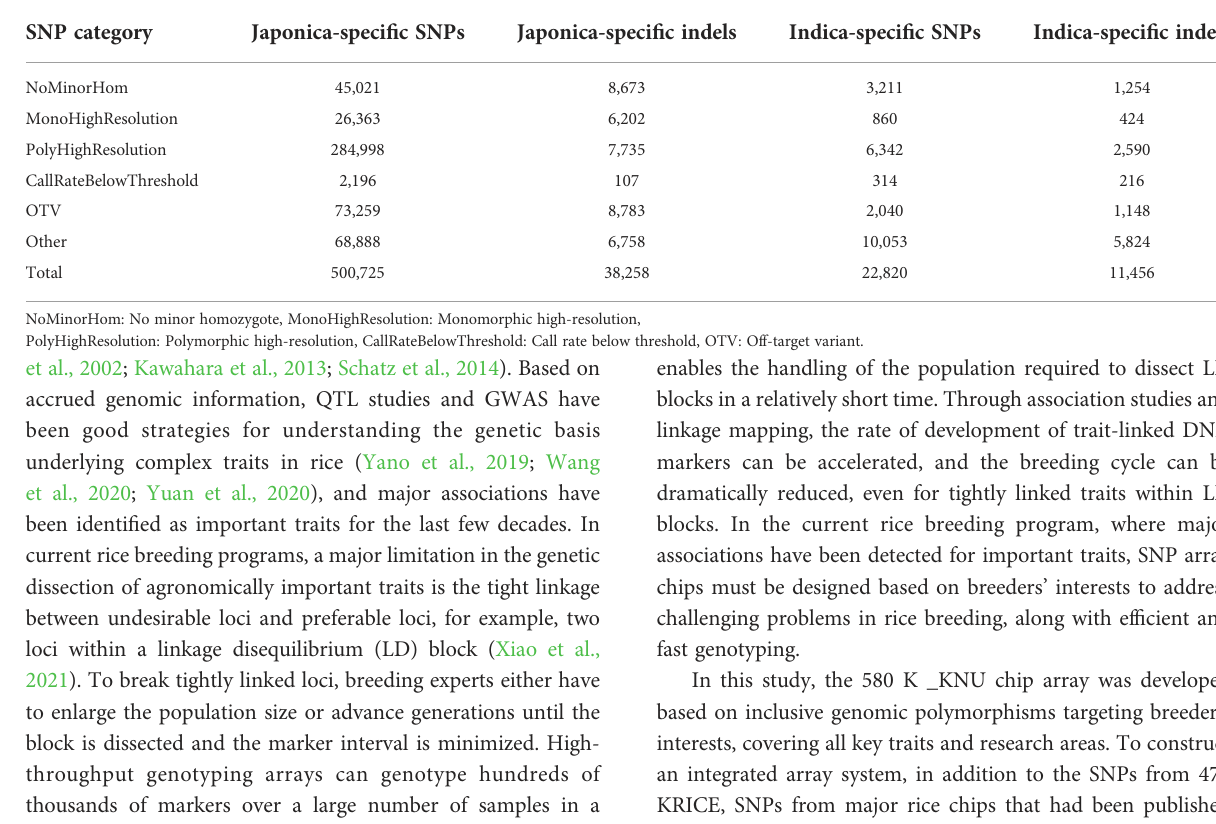
TABLE 1 Classi fi cation of SNPs in the 580K SNP Chip after genotyping on 4720 accessions.